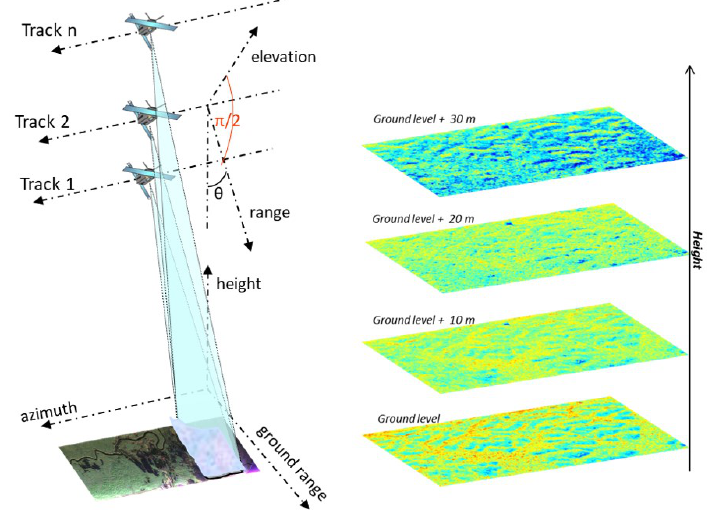
Figure 1. Example of tomographic focusing at a specific height with respect to the